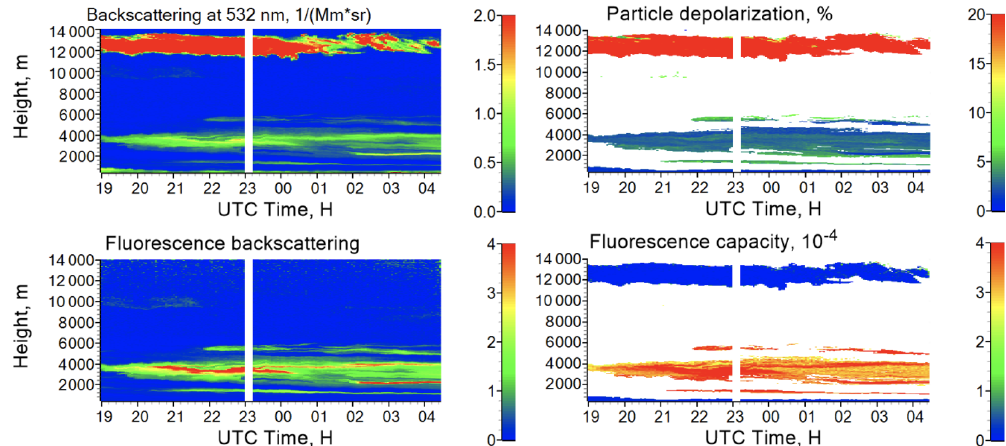
Figure 4. Spatiotemporal distributions of the backscattering coefficient β 532 , the fluorescence backscattering coefficient β F (in 10 − 4 Mm − 1 sr − 1 ), the particle depolarization ratio δ 532 , and the fluorescence capacity G F on the night of 12–13 September 2020. The calculation of δ 532 and G F was not performed for β 532 < 0.2Mm − 1 sr − 1 . The values of the backscattering coefficient and the depolarization ratio of ice clouds are high (above 20Mm − 1 sr − 1 and 40%, respectively) and are off the scale for the maps presented.